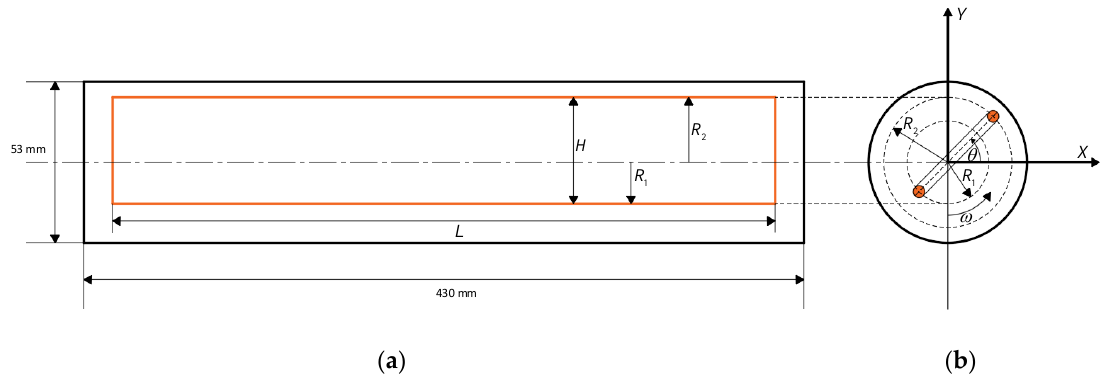
Figure 1. Rotating coil: ( a ) search coil; ( b ) orbit of a dipole magnetic field.